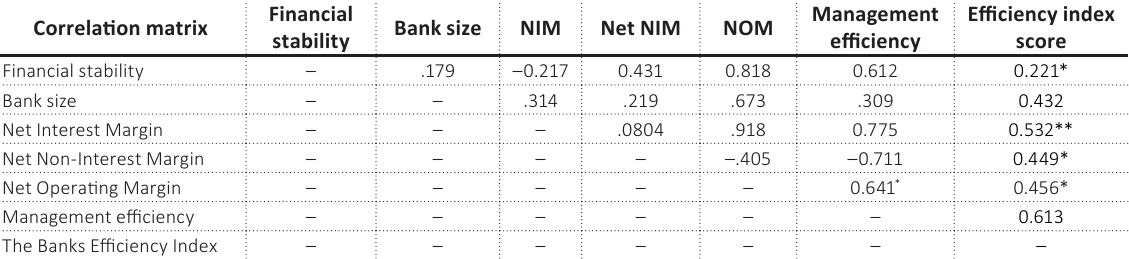
Table 7. Correlations matrix for Model B